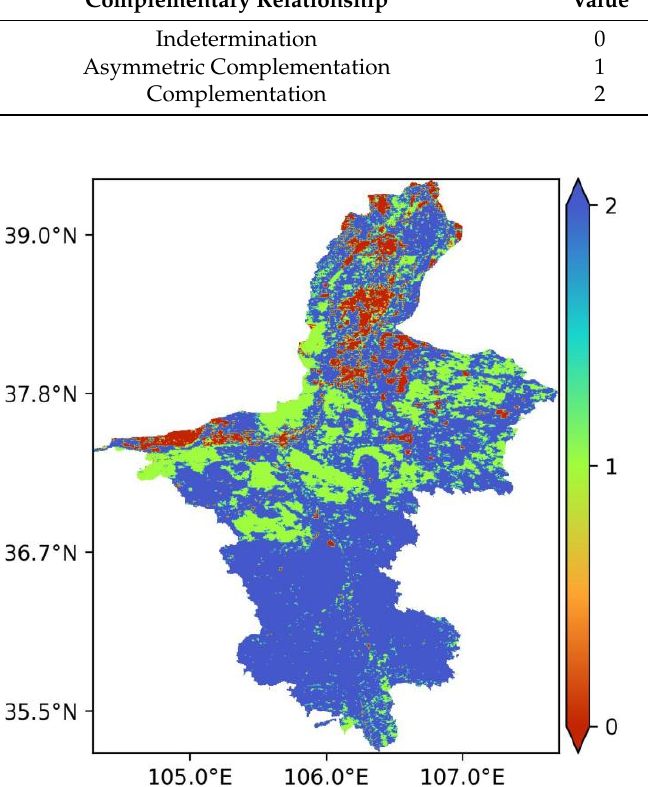
Figure 5. Spatial distribution of the complementary relationship between AET and PET.